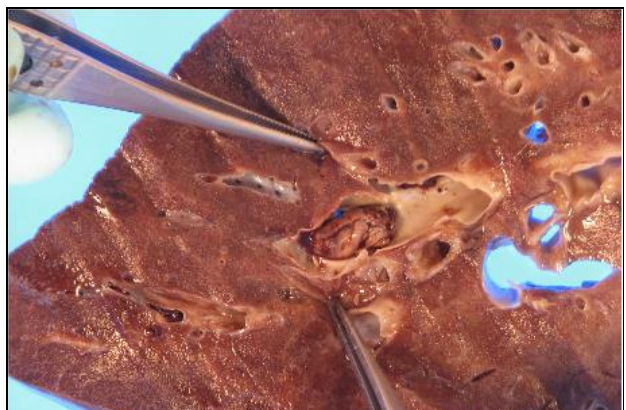
Figure 2. A thromboembolus at the right lower lobe of the lung of a deceased COVID-19 patient. Figure courtesy of Dr. Sharon Mount from the University of Vermont Medical Center.